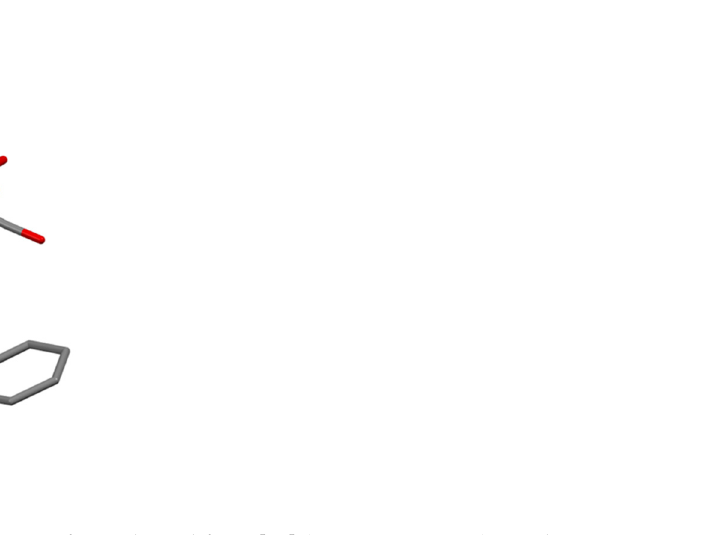
Figure 26. Molecular structure of 27 , adapted from [80] (MERCURY view). Hydrogen atoms are omitted for clarity (Sn light blue, O red, Os dark blue, C grey,).